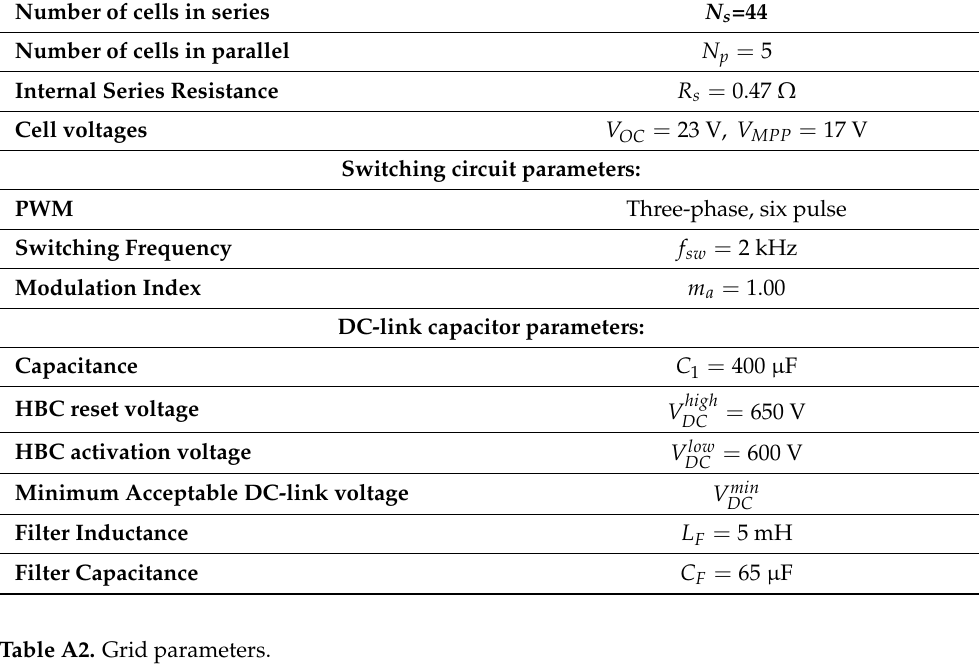
Table A1. PV array parameters.